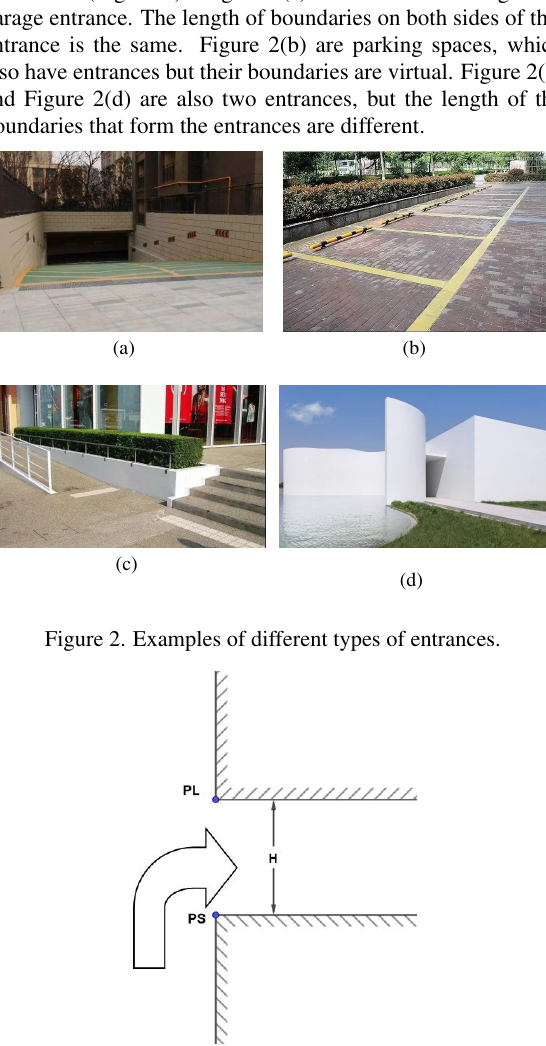
Figure 3. Modelling of